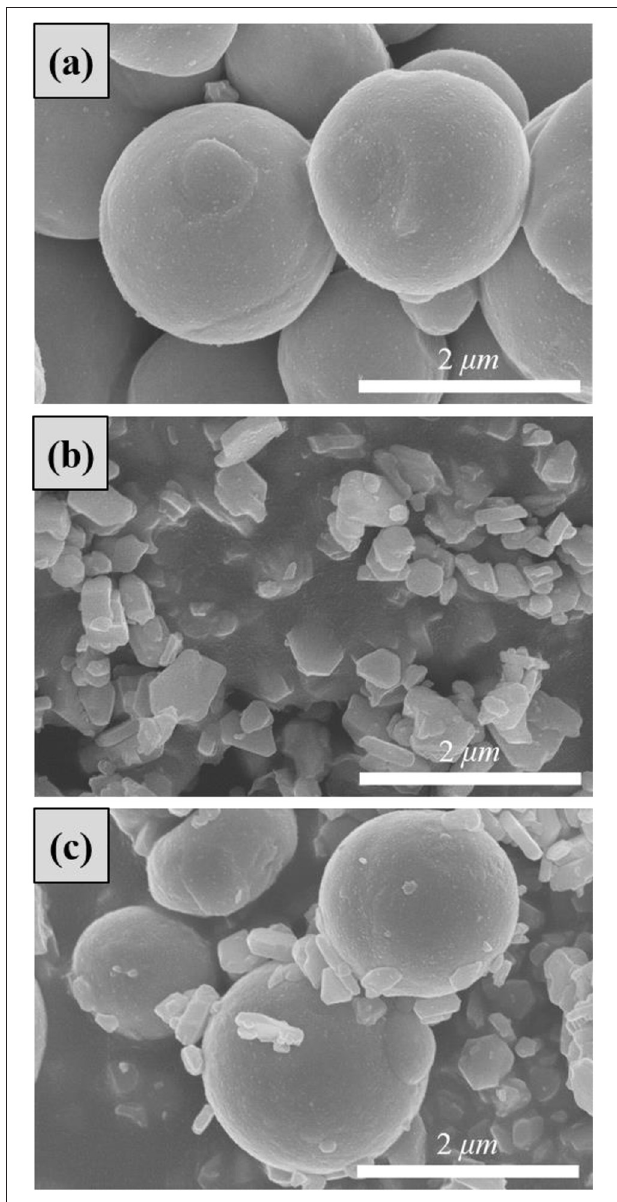
FIGURE 1 | Scanning electron microscopy images of (a) pure carbonyl iron (CI) microparticles, (b) BaFe 12 O 19 nanoparticles, and (c) CI/ BaFe 12 O 19